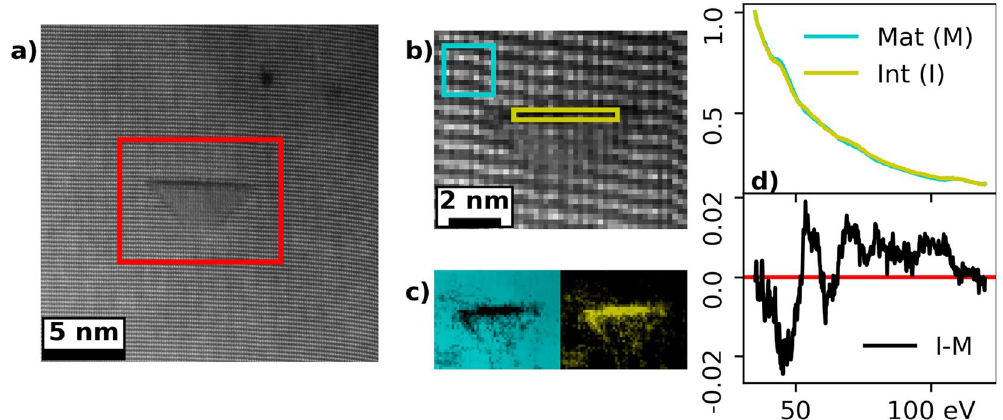
Figure 7. STEM-EELS mapping by MLLS of a PID observed in the < 1 ¯ 100 > direction. ( a ) shows the HADF- STEM overview image of the analyzed PID, with a red rectangle marking the analyzed region. ( b ) is the simultaneously acquired HAADF-STEM image of the spectrum image with the MLLS reference regions (blue matrix and yellow Mg rich) marked. ( c ) shows the maps for matrix and Mg rich regions in their corresponding colors. ( d ) shows the respective intensity normalized components in their corresponding colors, from 35 to 120 eV. The difference between these two (I−M) is shown in the lower